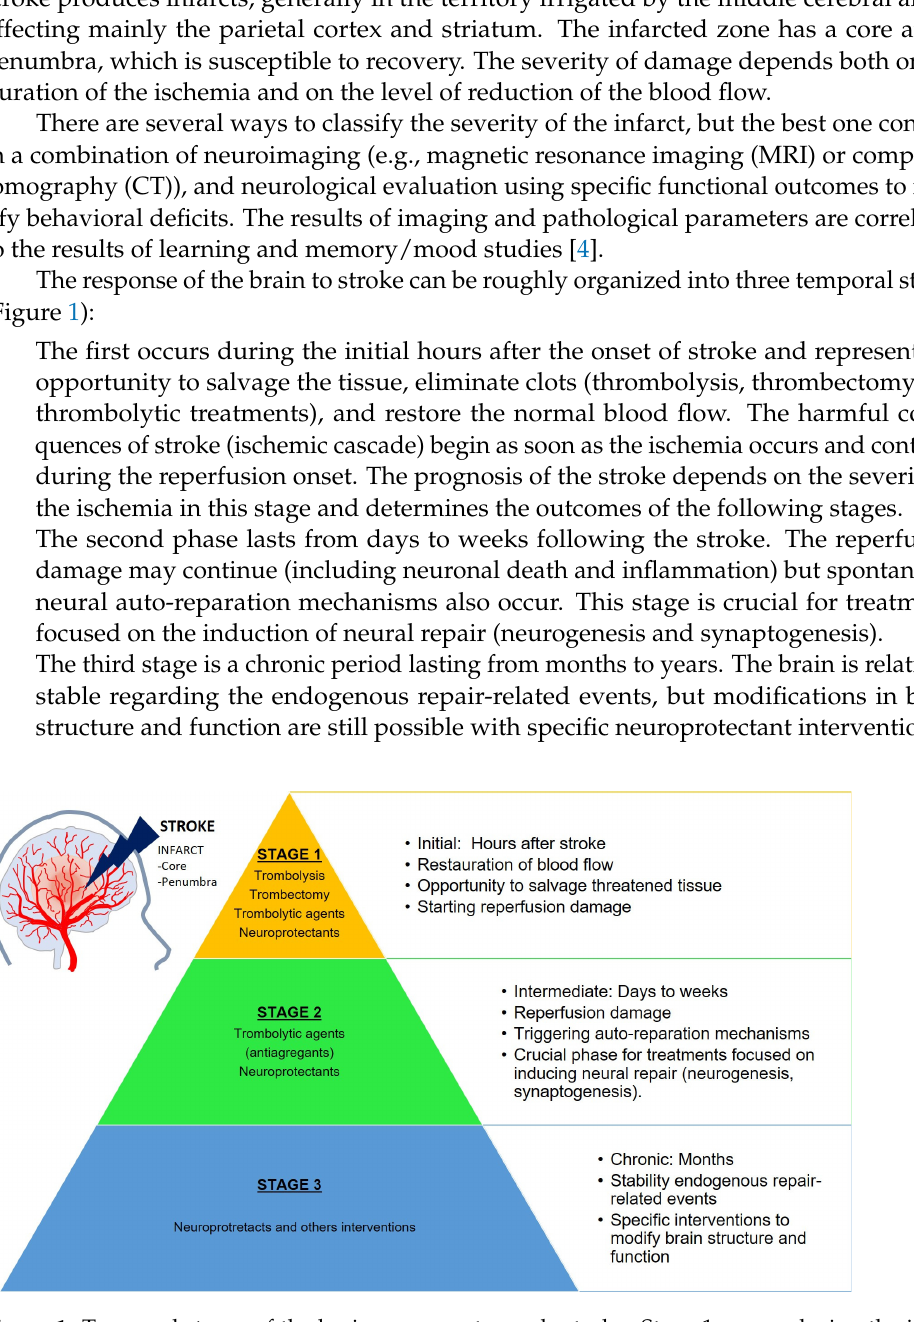
Figure 1. Temporal stages of the brain response towards stroke. Stage 1 occurs during the initial hours after the onset of stroke and represents an opportunity to salvage the threatened tissue, e.g., via reperfusion or neuroprotection. Stage 2 starts days to weeks following stroke and is crucial for treatments focused on the induction of the neural repair, as spontaneous neural repair may occur. Stage 3 represents a chronic phase where the brain is relatively stable with regards to endogenous repair-related events, although some modifications in brain structure and function are still possible with specific